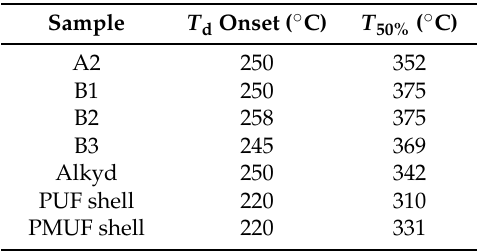
Figure 8. 1 H-NMR spectra of extracted core of sample B2.